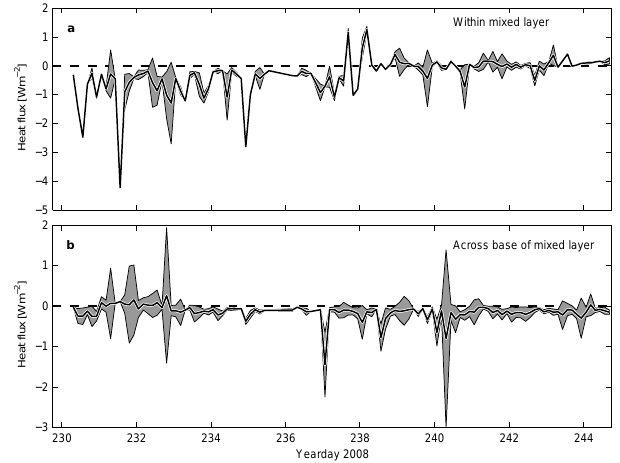
Fig. 9. Time series of heat fluxes averaged (a) within the mixed layer and (b) across the base of the mixed layer. Mixed layer fluxes are depth averages down to 4m above the mixed layer depth. Heat fluxes across the base of the mixed layer are depth averages from 4m above to 4m below mixed layer depth for each profile, averaged into 3-h intervals. Shading indicates ± one standard